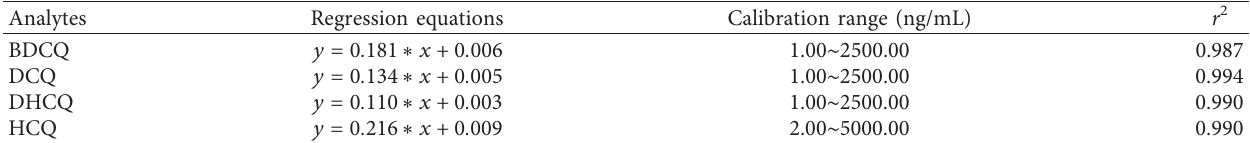
Table 3: Linear regression equation, range, and correlation coefficients of four analytes. Analytes Regression equations